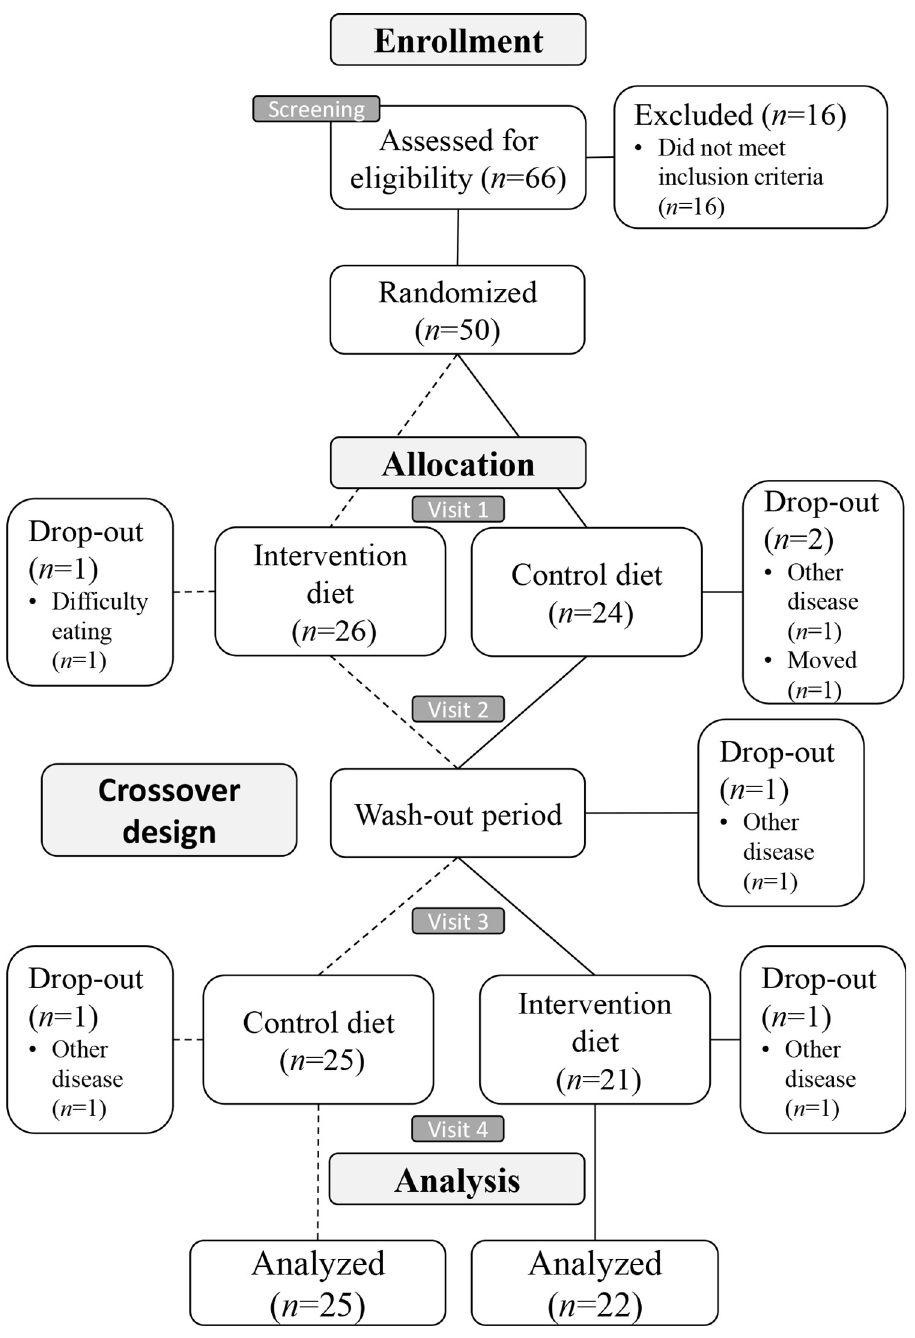
Fig 1. Flow diagram of the ADIRA